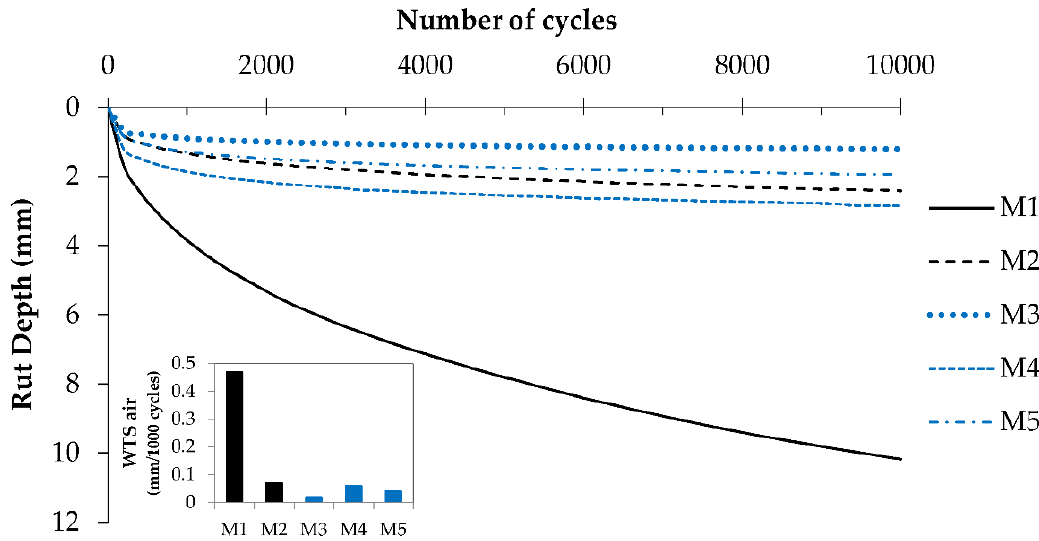
Figure 10. Evolution of the rut depth of the studied mixtures in the wheel tracking test (WTT) (the inset presents the resulting wheel tracking slope in air (WTS AIR ) values).